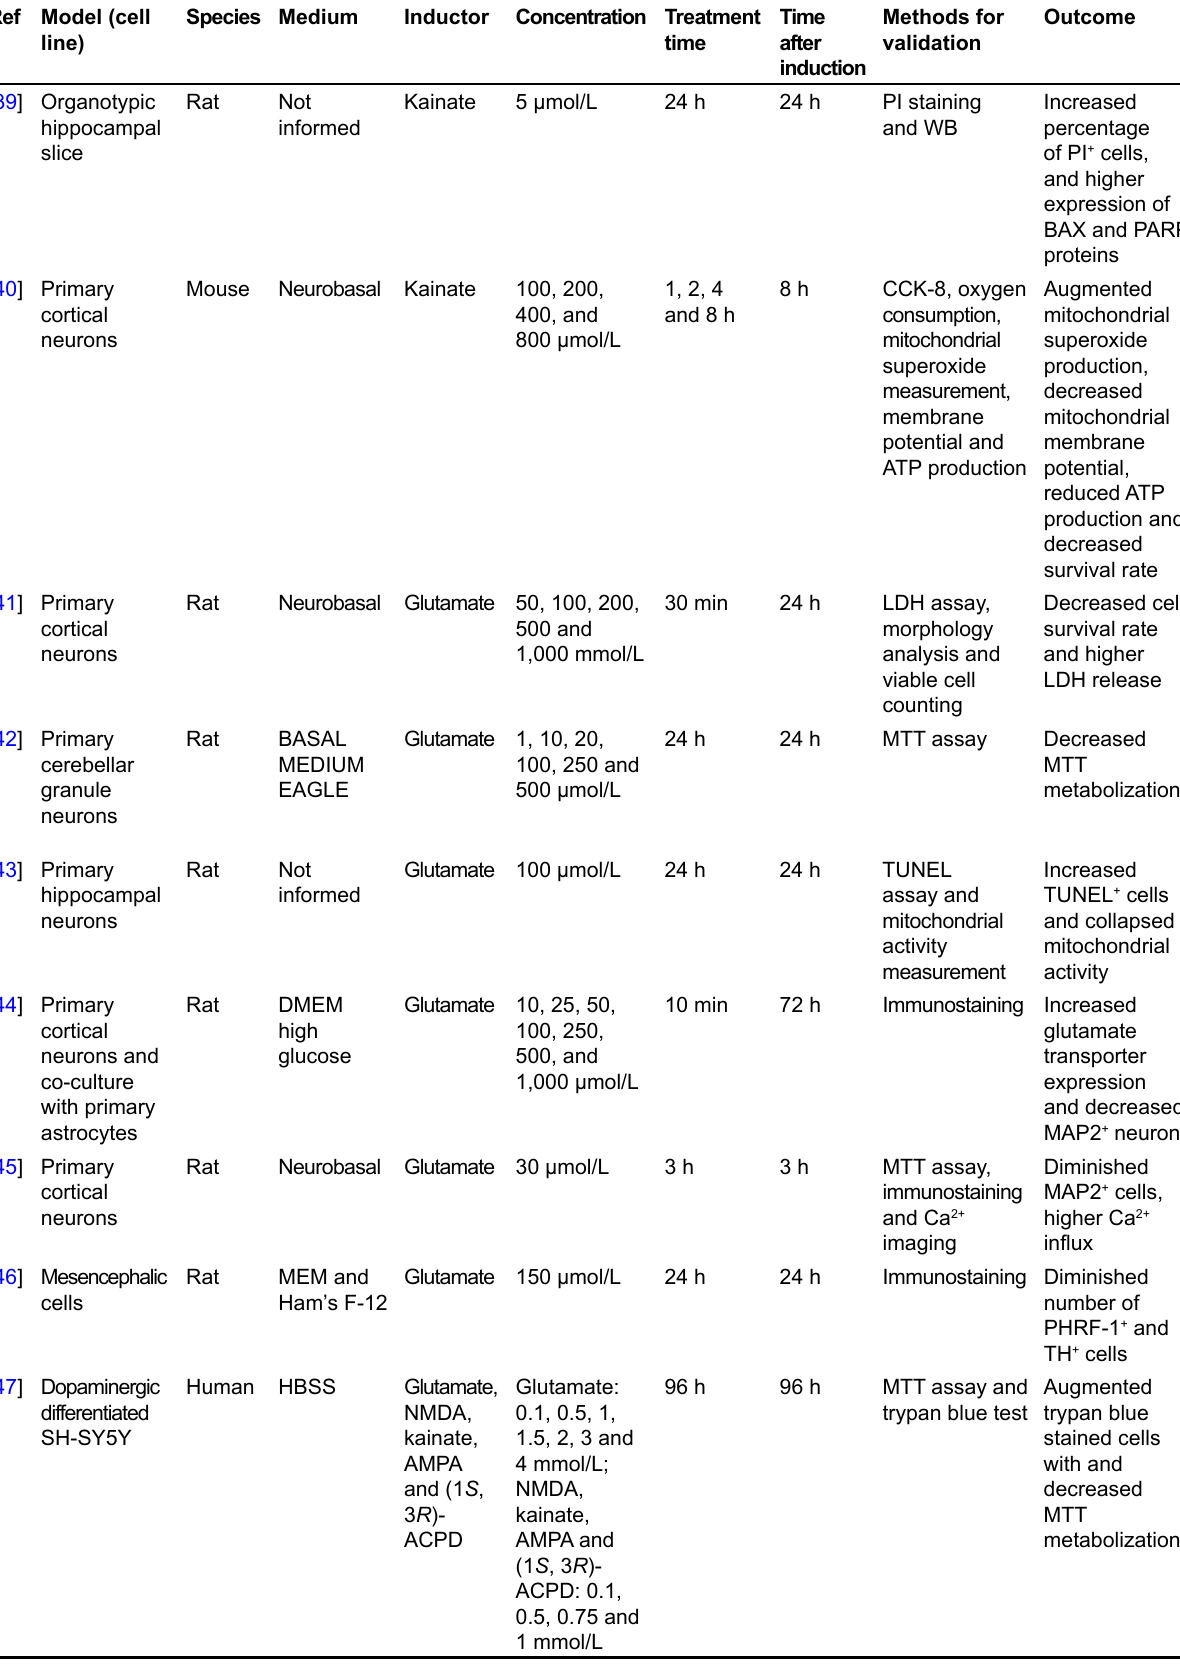
Table 1. Experimental aspects used in published excitotoxicity papers ( continued ) Ref Model